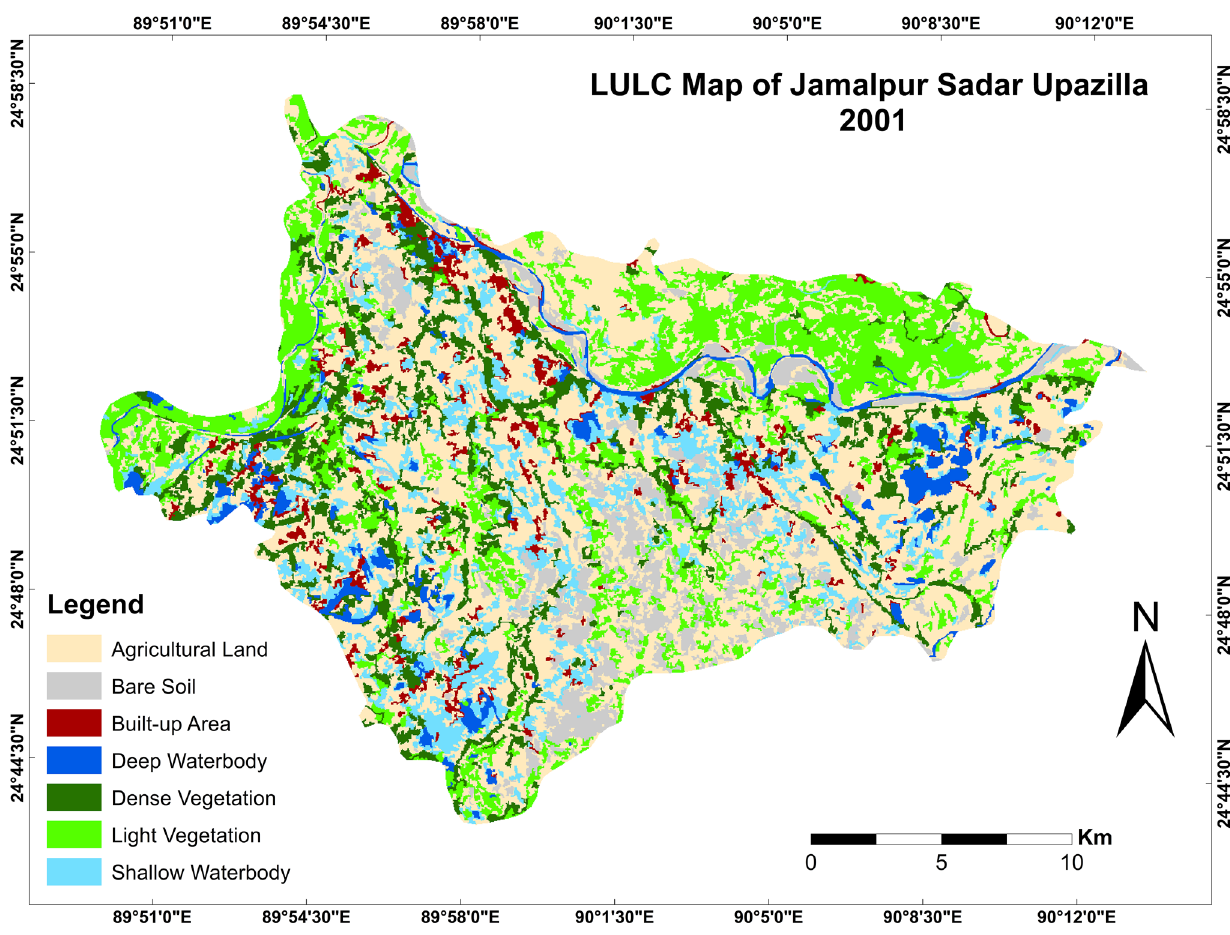
Fig. 4 Land use and land cover map of Jamalpur Sadar Upazila for the year